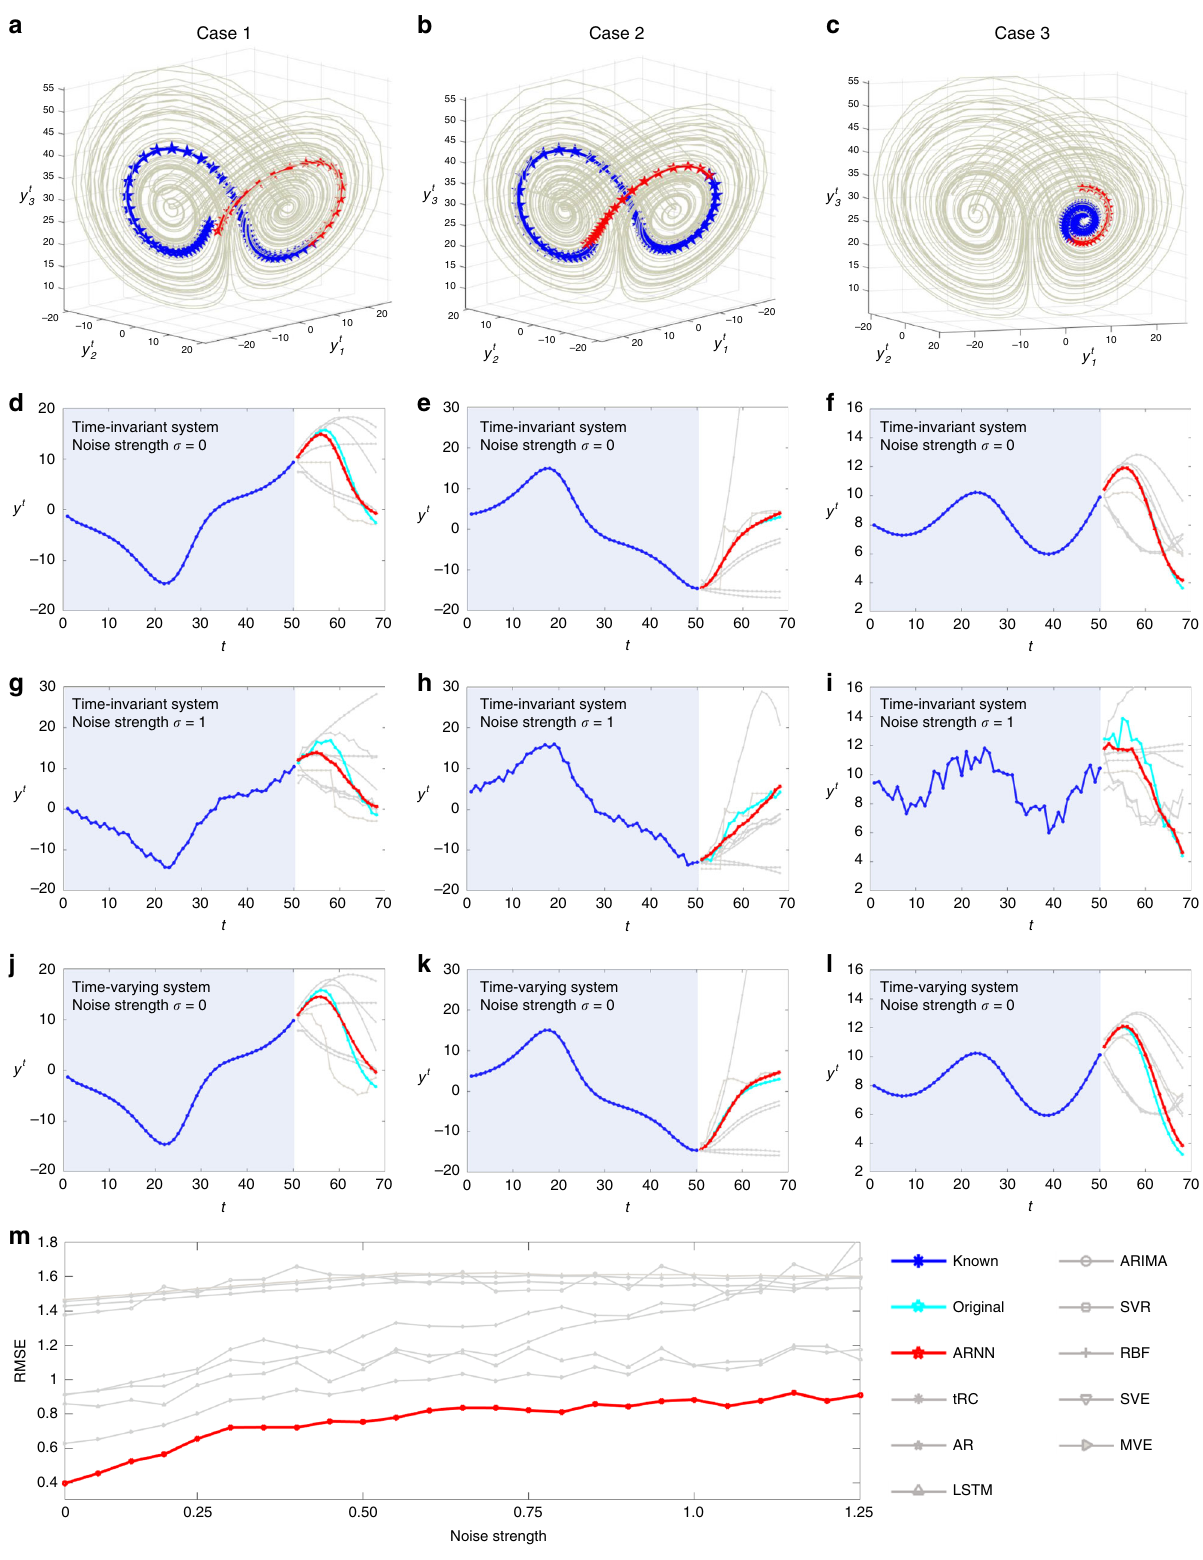
Additive noise situation . Second, we discuss the situation when there is additive noise. ARNN (Eq. (3)) and eight traditional prediction methods were applied to the 90D Lorenz system in Eq. (5) with different values of the noise strengths to predict